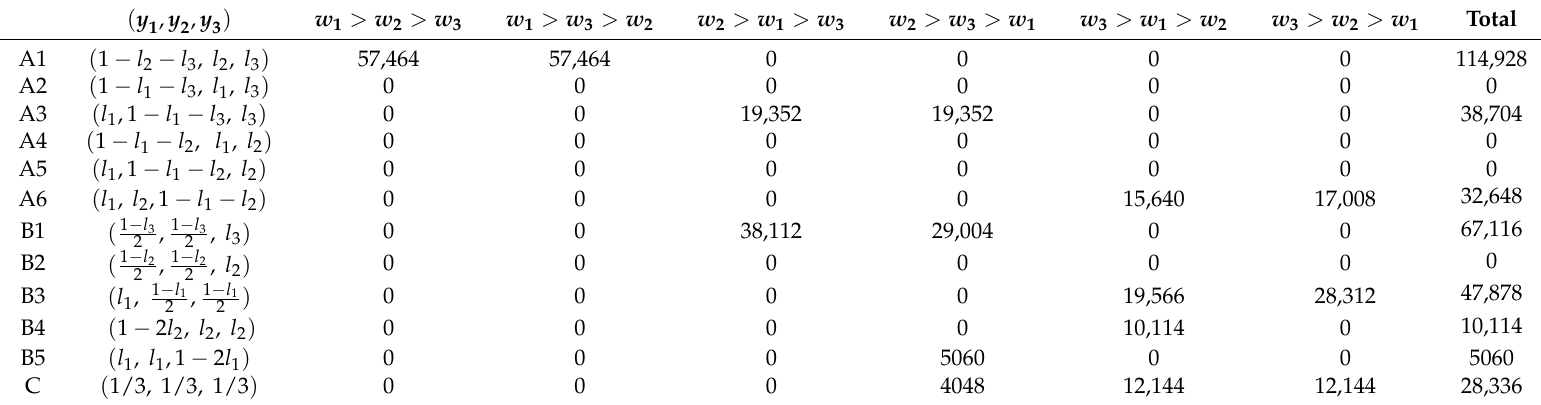
Table 4. The number of instances satisfying solution type and weight for 3COWAL with − 2 ≤ l 3 < l 2 < l 1 ≤